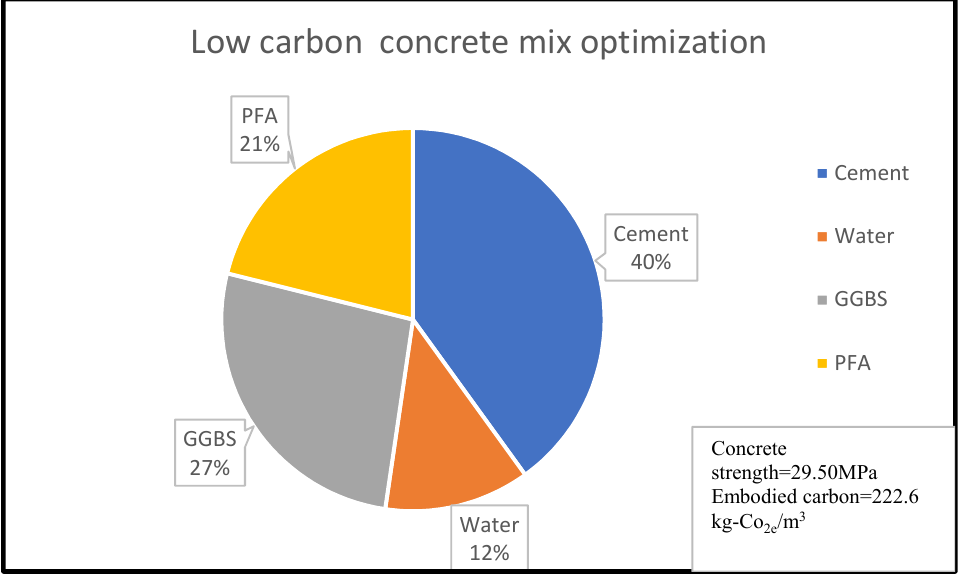
Figure 7. LCC constituent material at water content of 12% for Concrete Batch C [32]. Table 16. Summary of the optimised Embodied Carbon using the LP OPC = Ordinary Portland Cement, FA = Fine aggregate, CA = Coarse aggregate, w = Water, CH.A = Chemical admixture, GGBS = Ground granular base slag, PFA = Pulverised fly ash, NAOH = Sodium hydroxide solid, MEK = Metakaolin, NaSi = Sodium silicate, SF = Silica fume, EC = Embodied carbon, Concrete compressive strength.